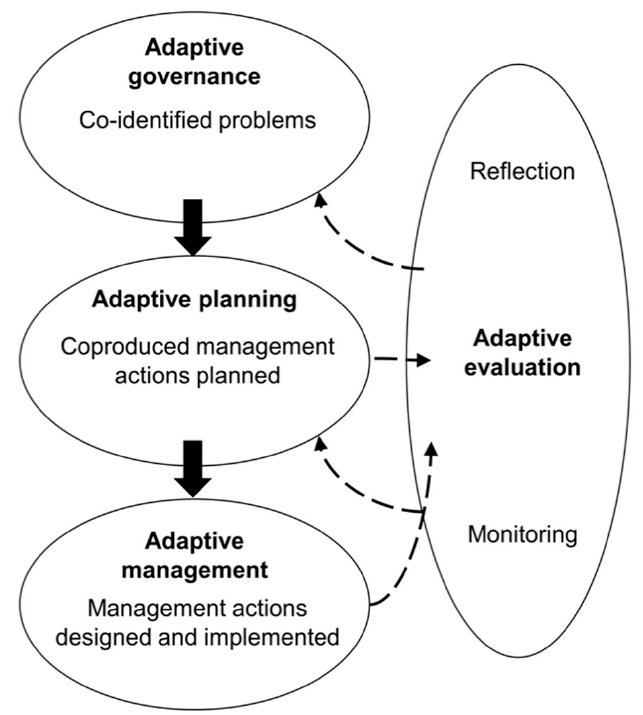
Figure 3. Adaptive management framework applied to establish a problem-solving plan for the transition to community-wide wildlife-friendly practices in ~400 coffee farmers in West Java, Indo-